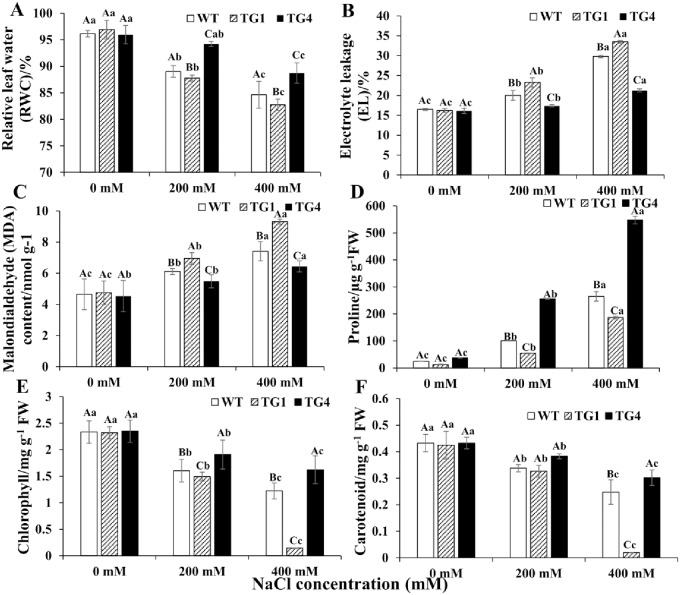
Physiological analysis of TG1, TG4 and WT plants under salt stress (0, 200 and 400 mM NaCl).(A) RWC, (B) EL, (C) MDA, (D) proline, (E) total chlorophyll (chlorophyll A + B), (F) carotenoid in TG1, TG4 and WT under salt stress. Value are mean ± SE (n = 3). The significance of treatment (0, 200 and 400 mM NaCl concentration) an sample type (WT and transgenic plants) was tested at the P < 0.05 level (two way ANOVA), capital letter represents the difference between WT and transgenic plants under the same salt concentration, lowercase represents the difference of WT or transgenic plants under 0, 200 and 400 mM NaCl concentration.